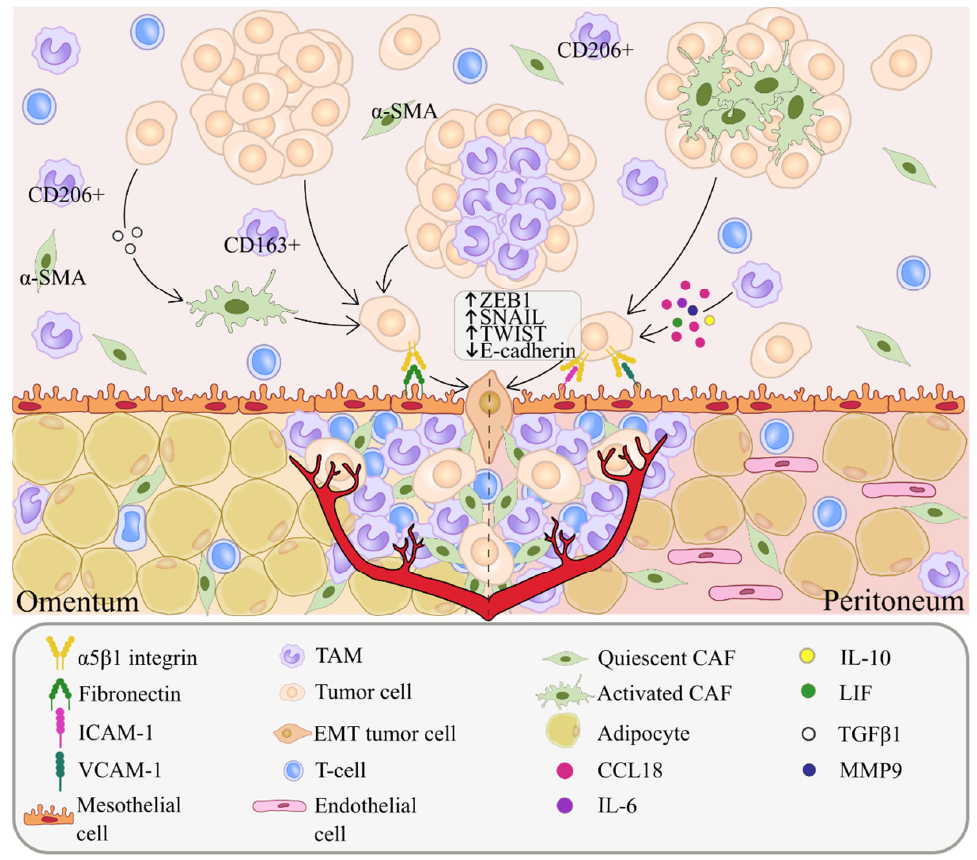
Figure 2. Mechanisms of implantation metastasis. α5β1 integrin on tumor cells binds to exposed fibronectin on mesothelial cells, facilitating the development of peritoneal metastasis. The morphology of implanted tumor cells resembles that of mesenchymal cells with increased expression of mesenchymal markers (ZEB1, SNAIL and TWIST) and decreased E-cadherin expression during invasion to the omentum/peritoneum. TAM-derived CCL18 promotes EMT in tumor cells. IL-10, IL-6, MMP9 and LIF produced by TAMs enable the implantation of tumor cells. TGFβ-activated fibroblasts induce the adhesion of tumor cells to a layer of mesothelial cells.